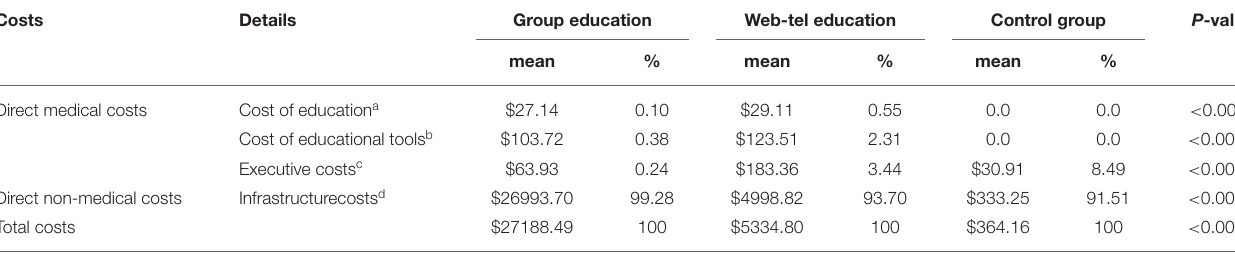
TABLE 2 | Comparison of costs among the three groups of patients with type 2 diabetes mellitus (T2DM).